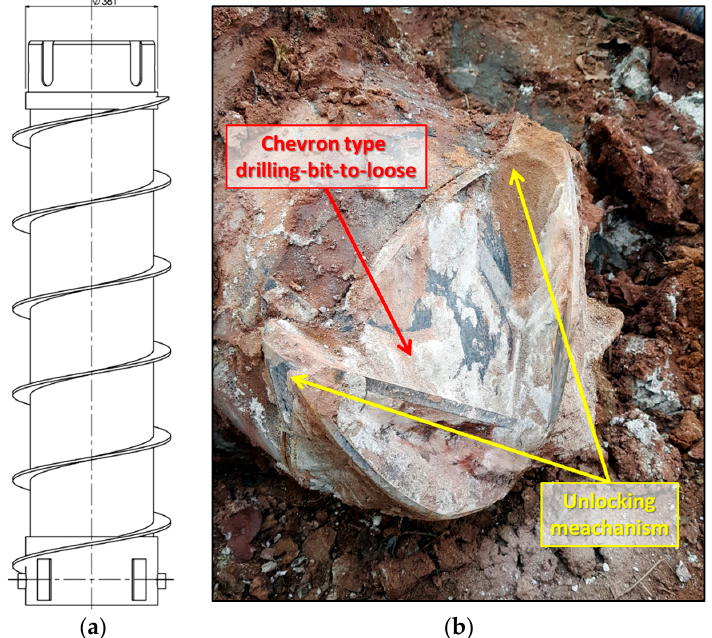
Figure 2. Enlarged easy drill technology (EEDT) tools: ( a ) casing segment with external spiral; ( b ) drag bit-to-loose for soft, clayey geological conditions.